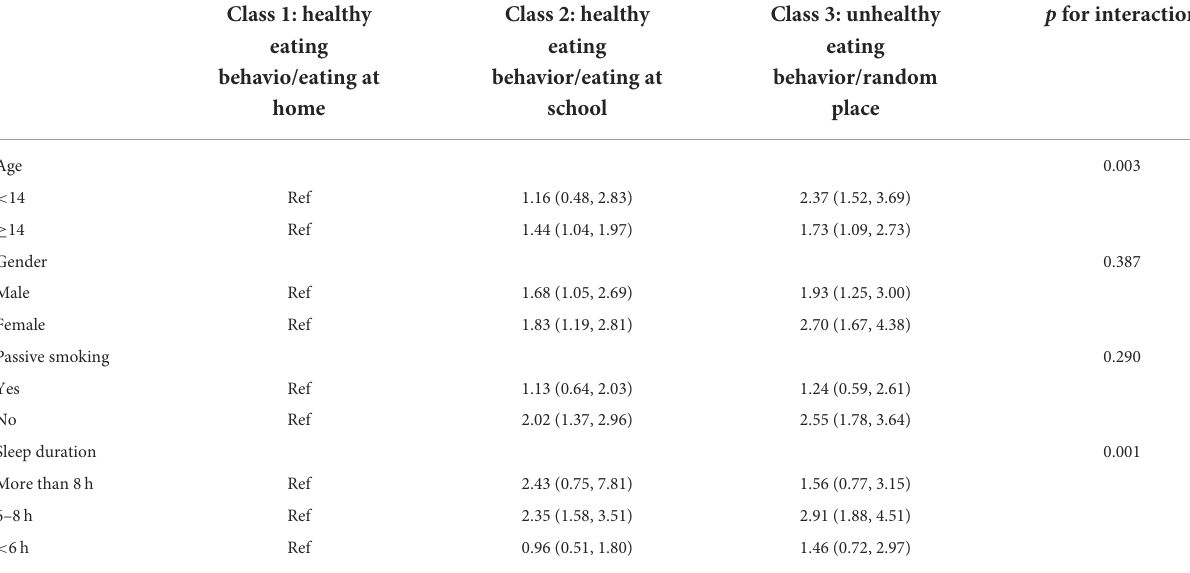
TABLE 8 Multivariable-adjusted odds ratios for the association between eating habits and mental health problems by